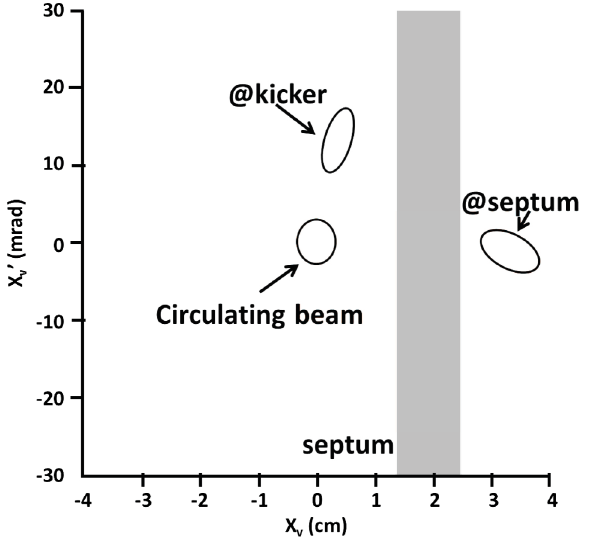
FIG. 34. Phase space motion for vertical